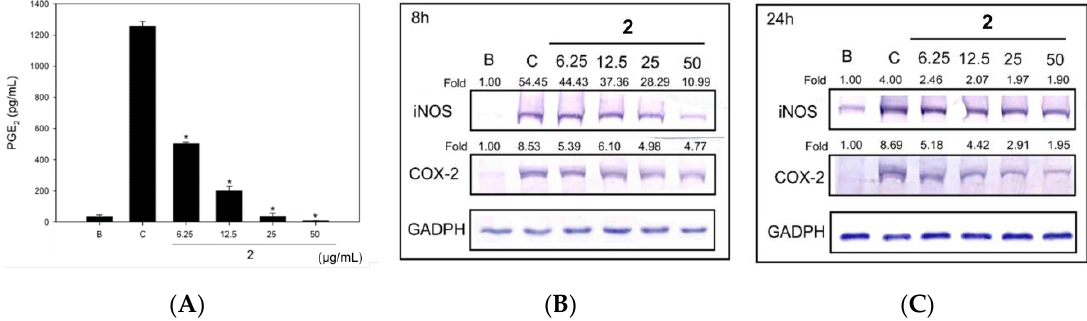
Figure 3. Anti-inflammatory effects of (+)- Erythro -( 7S,8R )-Δ8′,3,3′,5′-trimethoxy-8- O -4′-neolignan ( 2 ) ( A ) against HKC-induced PGE 2 inhibitory effects on nitric oxide synthase (iNOS) and cyclooxygenase (COX)-2 at 8 h ( B ) and 24 h ( C ). * p < 0.01 compared with Control; B: Blank (without HKC induction), C: Control (HKC induction without 2 treatment).